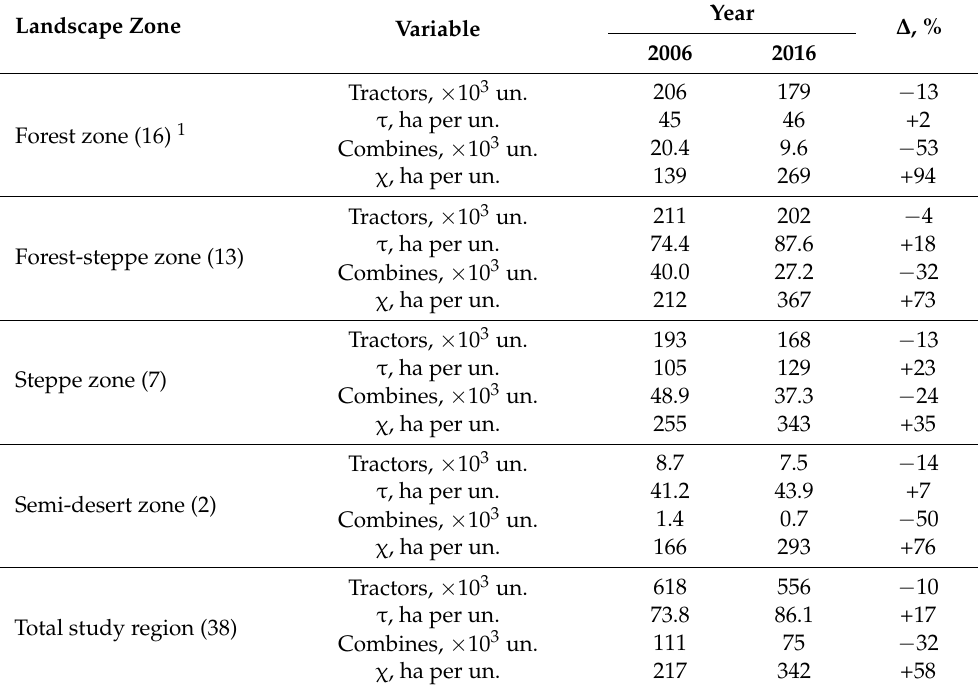
Table 4. Changes in the number of tractors and grain combine harvesters in the analyzed landscape zones of European Russia (see Figure 3) between 2006 and 2016. Year ∆ Landscape Zone Variable , % 2006 2016 Tractors, × 10 3 un. Forest zone (16) 1 Combines, × 10 3 un.